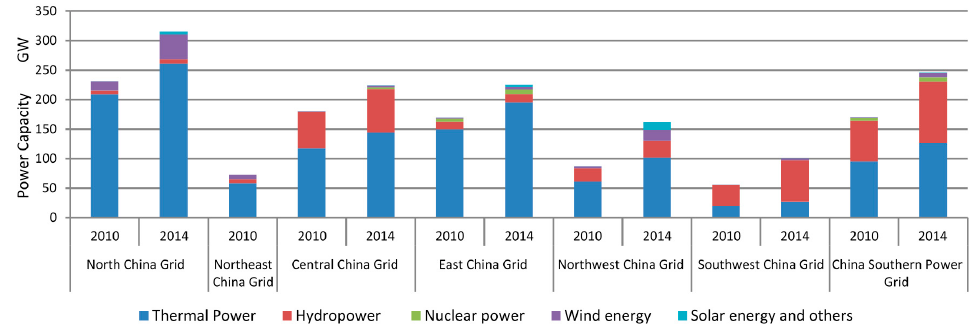
Figure 1. Power capacity in the regional grids in China in 2010 and 2014; unit: GW. Source: Reproduced with permission from [6,11].